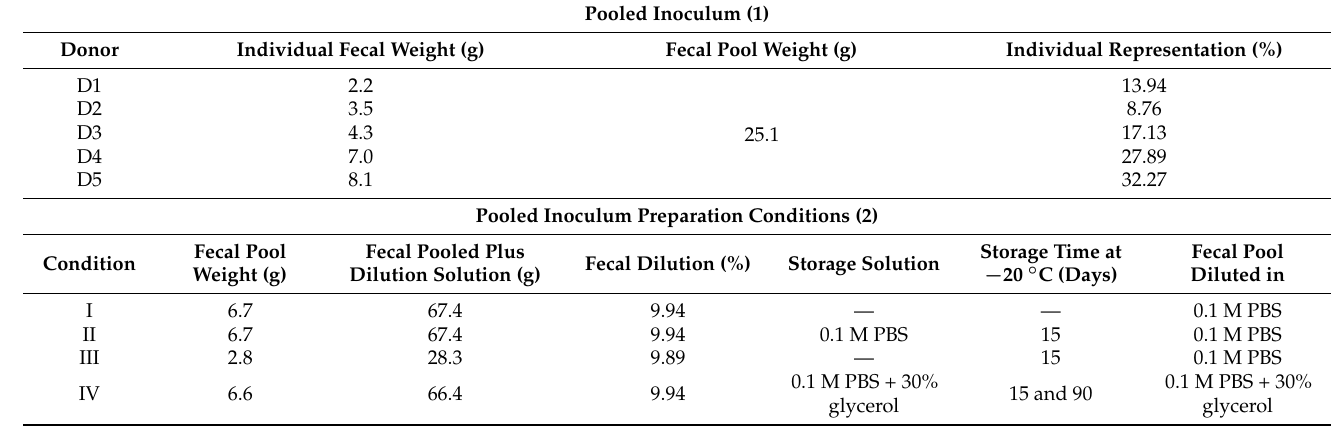
Table 2. Detailed Information on the Composition of the Pooled Inoculum ( 1 ), and Pooled Inoculum Preparation Conditions ( 2 ). Pooled Inoculum